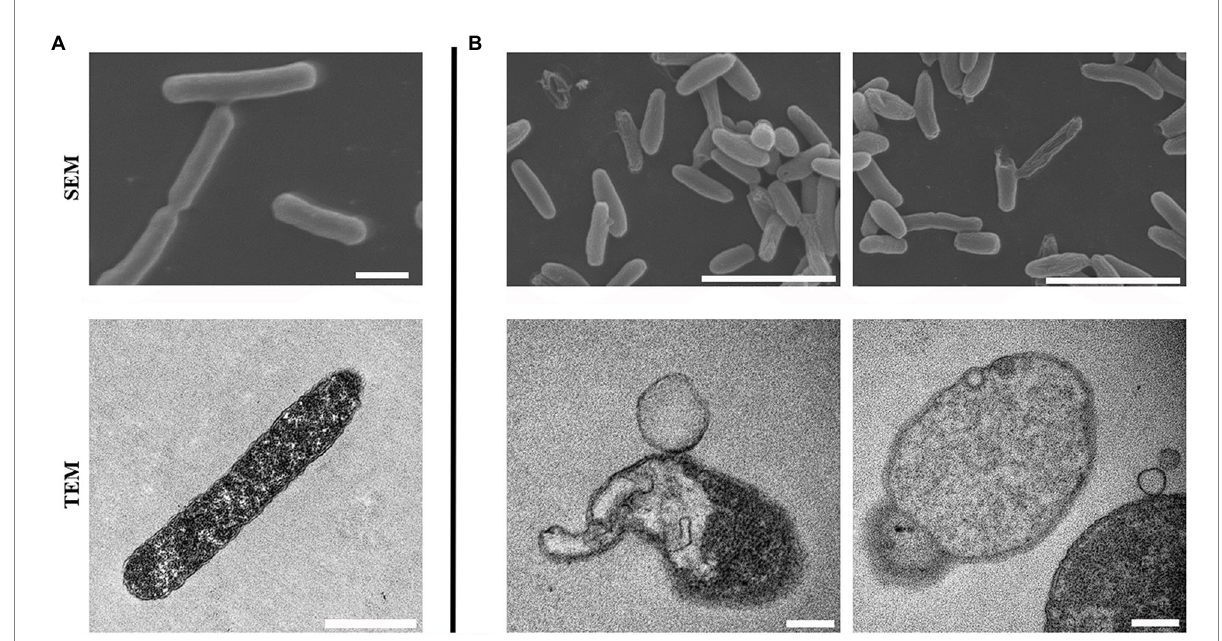
FIGURE 2 Morphologic and microstructural changes of Escherichia coli after being treated with 0390 for 1 h. Scanning electron microscopy (SEM) and transmission electron microscopy (TEM) images of (A) untreated, or (B) 32 μ g/ml of 0390 treated E. coli ATCC 25922. Scales for SEM: 5 μ m; for TEM: 1 μ